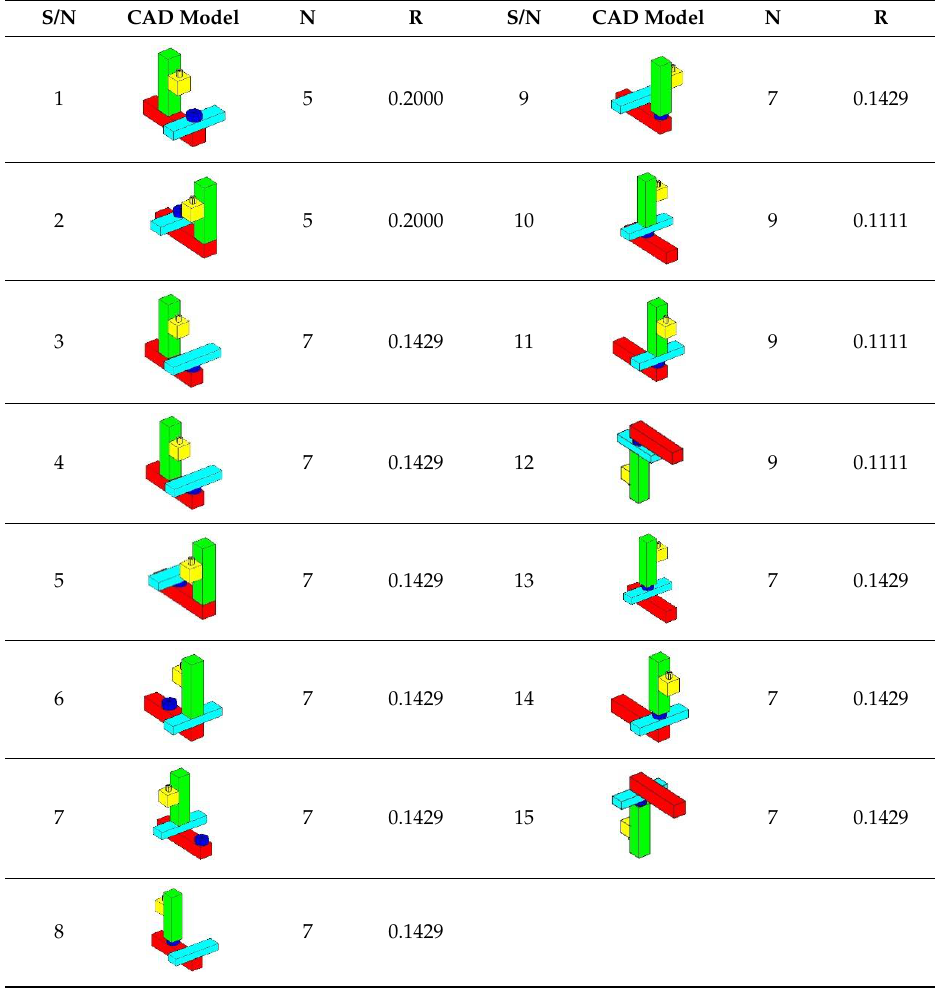
Table 7. Results of reconfigurability analysis.